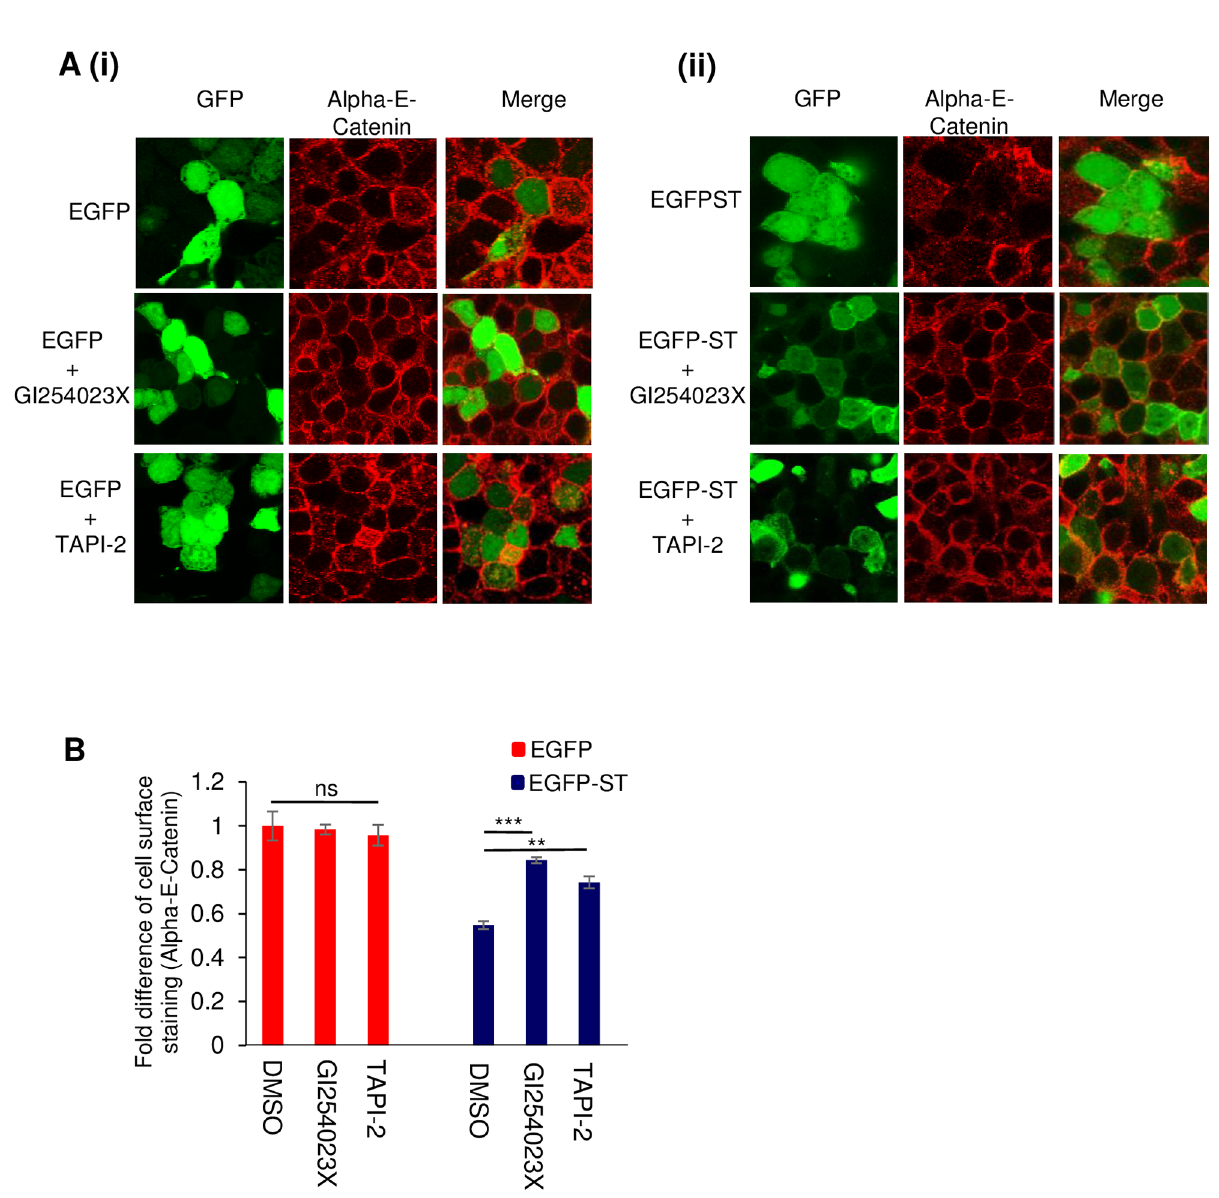
Fig 5. ADAM 10 is required for MCPyV ST-induced cell junction disruption. (A) HEK 293 cells were transfected with 1 μg of (i) EGFP or (ii) EGFP-ST expression plasmids and grown in the absence or presence of GI254023X or TAPI-2 inhibitors. 24 hours later cells were fixed and EGFP fluorescence analysed by direct visualisation, whereas endogenous Alpha-E-Catenin was identified by indirect immunofluorescence using a specific antibody. The top panel for both (i) and (ii) is the same as Fig 1A. (B) EGFP or EGFP-ST transfected HEK 293 cells were grown in the absence or presence of GI254023X or TAPI-2 inhibitors for 24 hours, then harvested and stained with an Alpha-E-catenin specific antibody and Alexa-Fluor- tagged secondary antibody. Mean fluorescence intensity was analyzed using FlowJo software. Fold difference of cell surface staining was calculated using three replicates per experiment, n = 3 by a two-tailed t-test with unequal variance, (cid:3)(cid:3)(cid:3) = p < 0.001 and (cid:3)(cid:3) = p < 0.01.